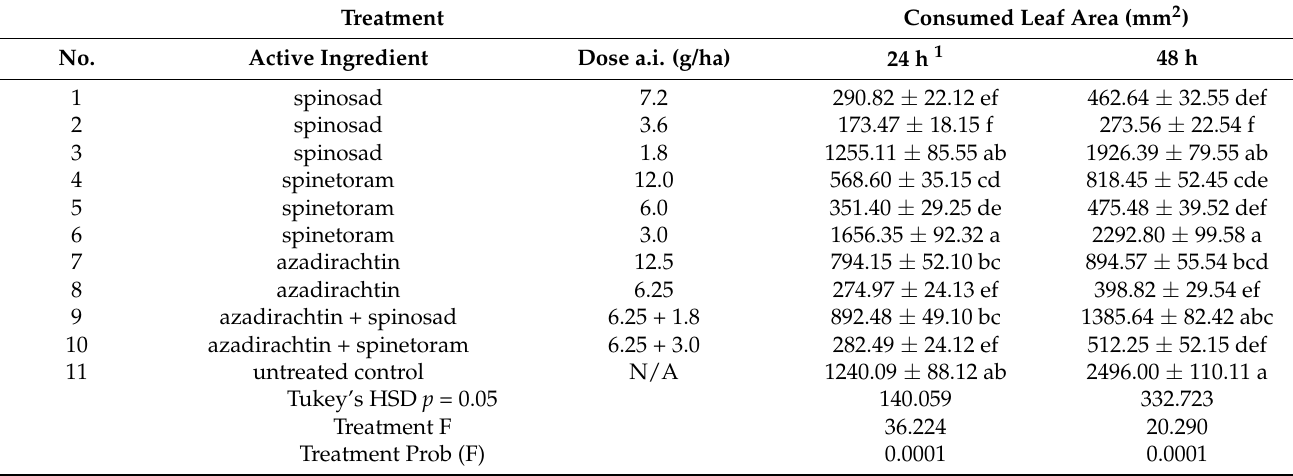
Table 4. Potato leaf area consumed ( ± SE) by Colorado potato beetle larvae 24 and 48 h after treatment.